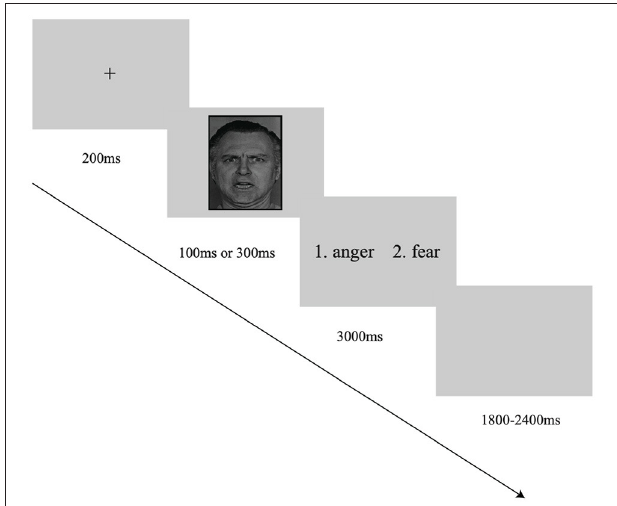
FIGURE 1 | The illustration of a single trial in the facial expression recognition task. The facial expression image was obtained from the Ekman database (Ekman and Friesen,